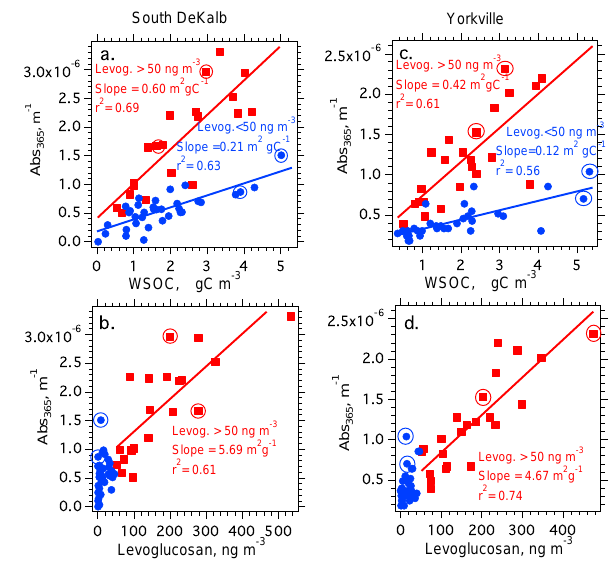
Fig. 6. Relationship between absorption coefficient at 365nm (Abs 365 ), WSOC and levoglucosan at a representative urban (South Dekalb, (a) and (b) ) and rural (Yorkville, (c) and (d) ) site. Absorp- tion spectra for the circled data points are shown in Fig.